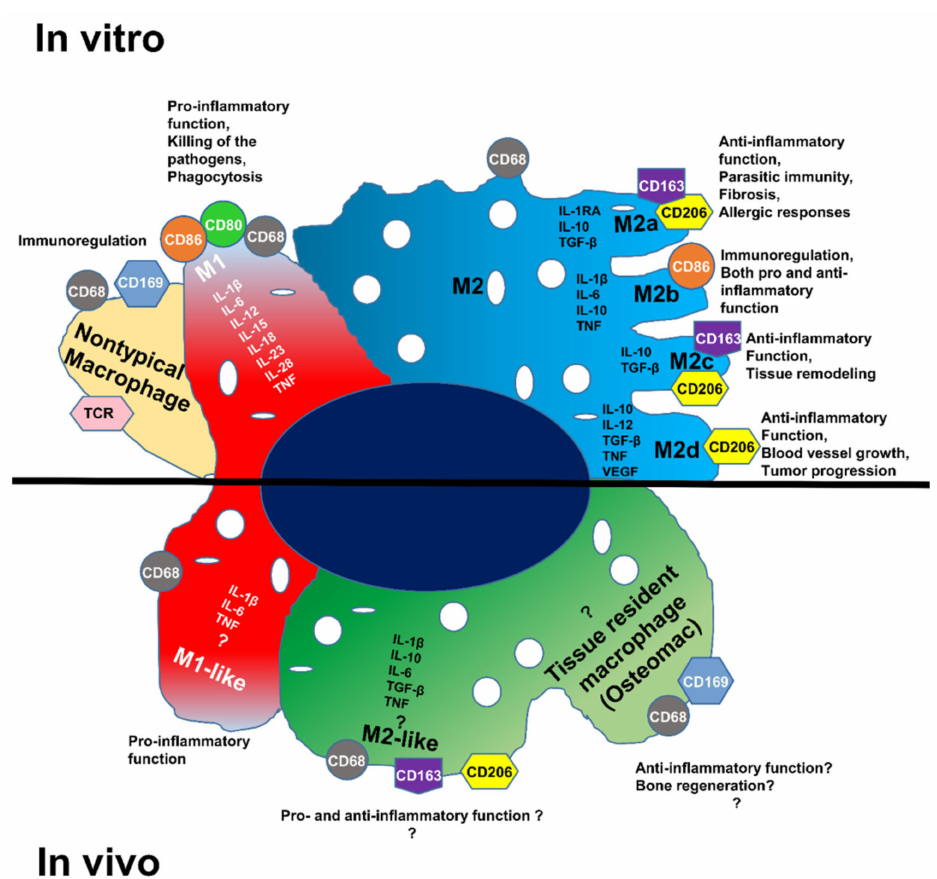
Figure 1. Macrophage polarization subtypes; different cytokine expressions and functions of the macrophage populations in vitro and in